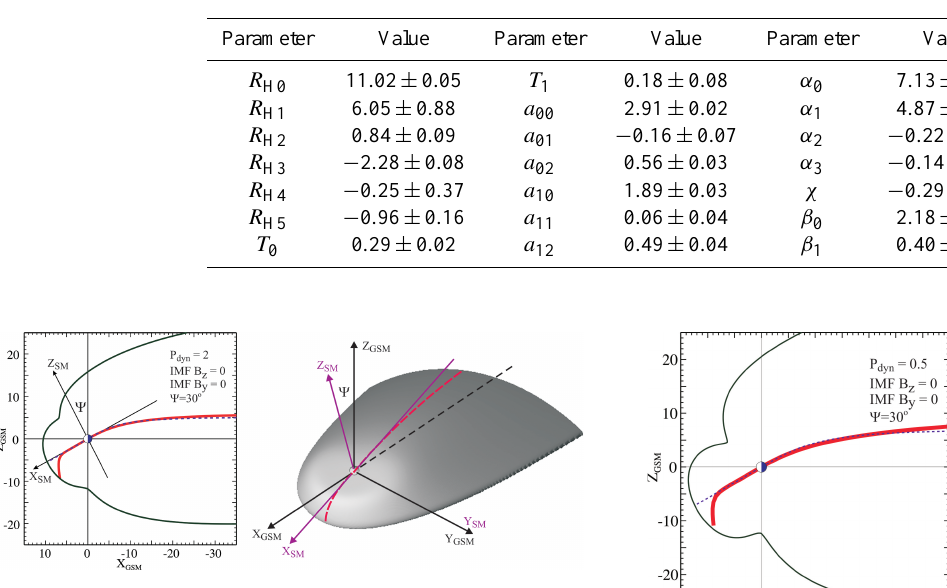
Figure 5. Left: noon–midnight section of the model surface B r = 0 for average interplanetary conditions and dipole tilt angle (cid:57) = 30 ◦ (heavy red contour). In this and following figures, the blue dashed line shows the result of the TF04 model, obtained for the same values of input parameters. The model magnetopause by Lin et al. (2010) is also shown with a magenta solid line. Right: a 3-D view of the deformed bowl-shaped model surface for the same in- put parameters.